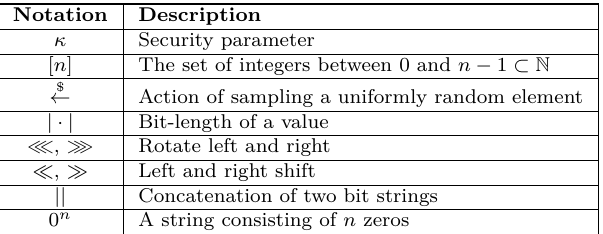
Table 1: Some important